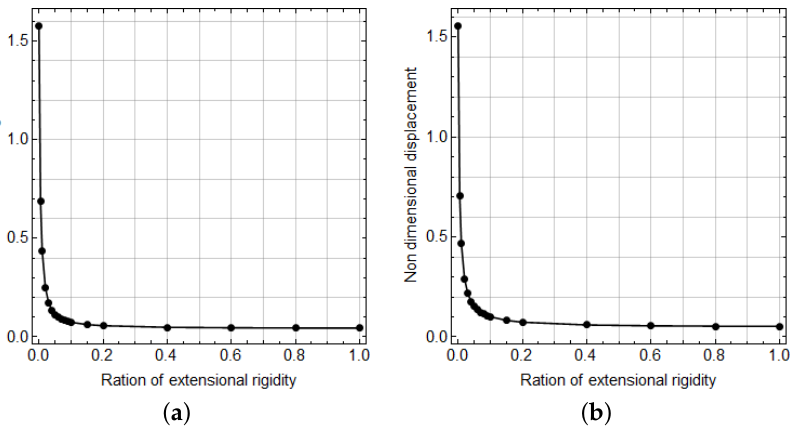
Figure 16. Effect of the ratio of extensional rigidity α in Case 1-2 with central vertical reinforcing member: ( a ) nondimensional stress; ( b ) nondimensional displacement.